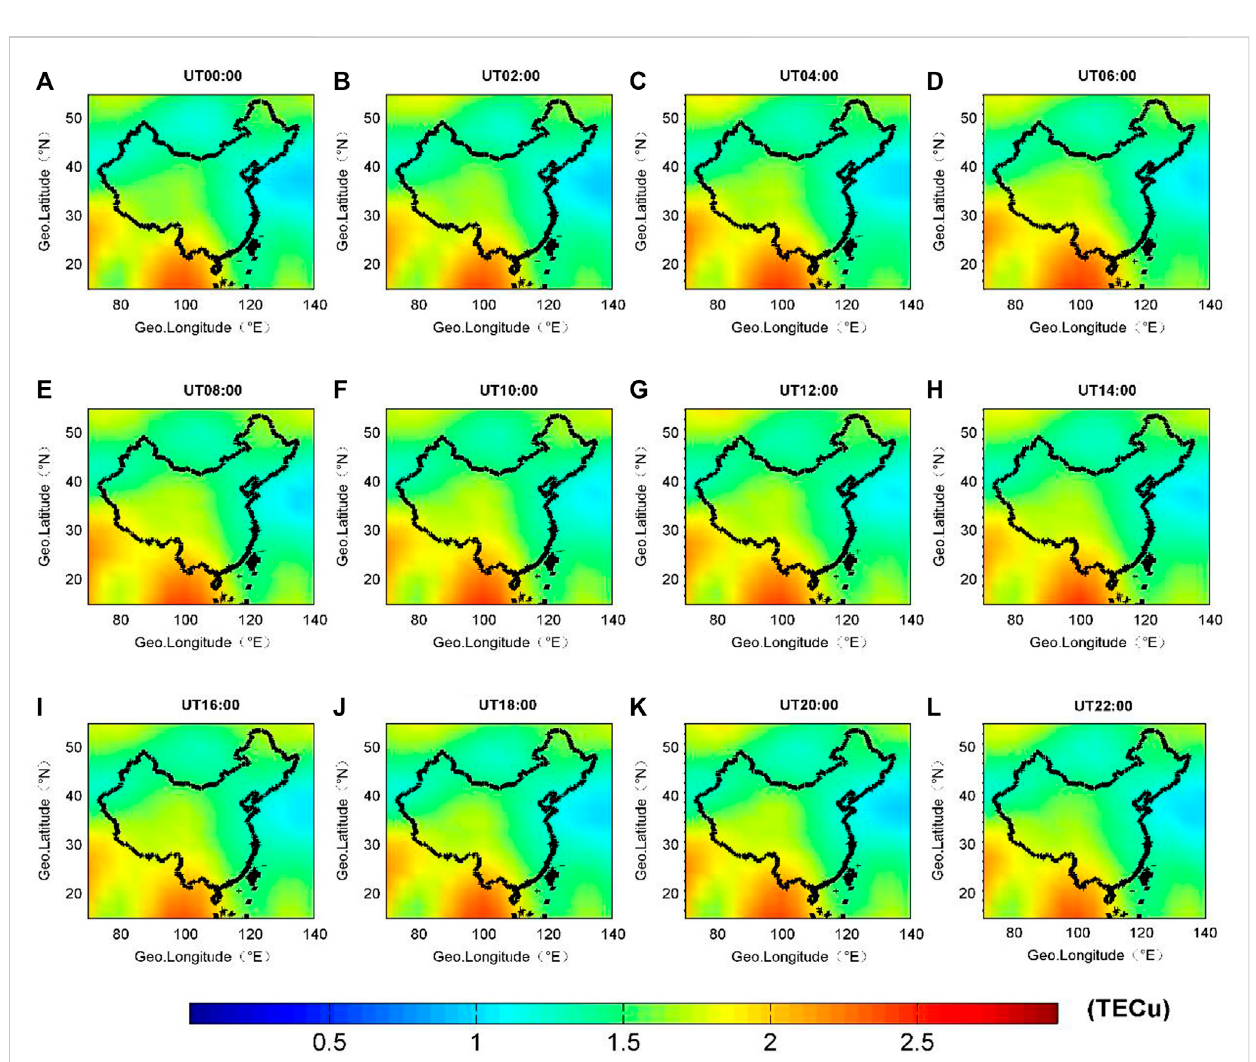
FIGURE 4 Thespatial distributionoftheRMSoftheIGSGIM.Ineachpanel,the x -axisand y -axisrepresent geographic longitude andlatitude,respectively, and the color scale indicates the magnitude of TEC in